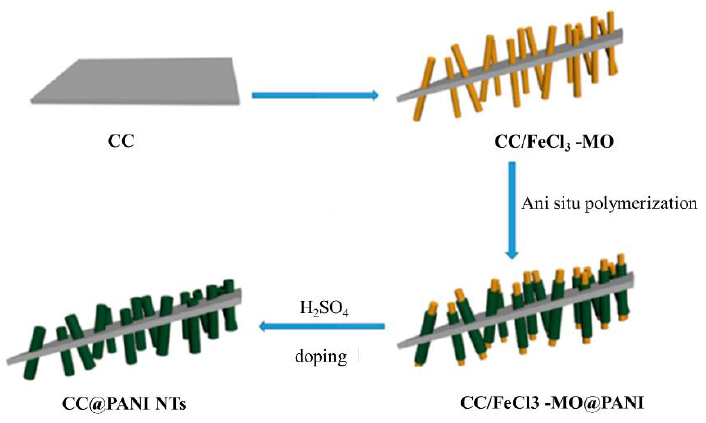
Figure 28. Schematic of the fabrication route of CC@PANI NTs.